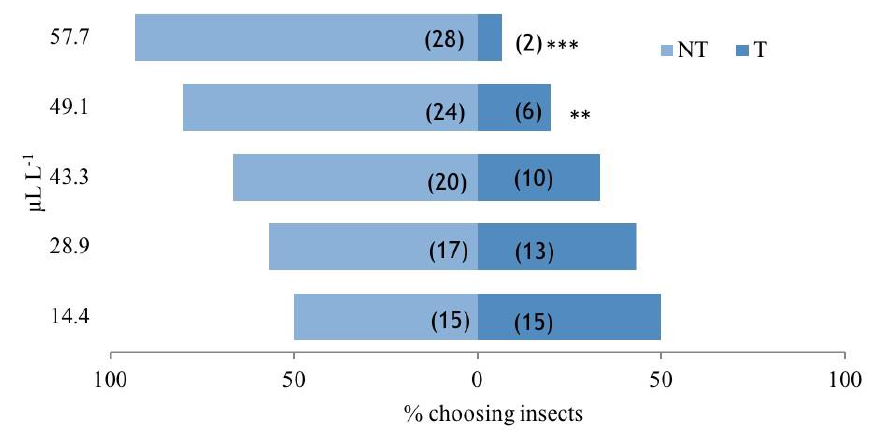
Figure 1. Behavior of Acanthoscelides obtectus females in the presence of Ferulago campestris essential oil. Histograms represent the percentage of insects that chose the cue or the control chamber. On the y axis are reported the concentrations of the cue tested ( µ L of EO L − 1 air). Numbers in brackets indicate the number of choosing insects; NT, percentage of insects that chose the control chamber; T, percentage of insects that chose the EO treated chamber. Asterisks indicate significant differences in the number of the choosing insects according to a χ 2 test (** p < 0.01; *** p < 0.001).